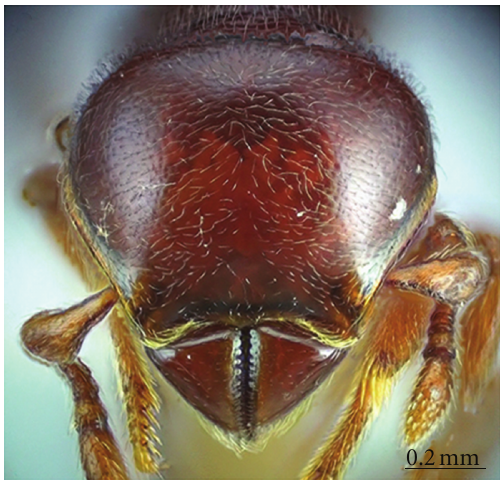
Figure 2: Tatuidris kapasi : holotype worker. Head: full-face view.